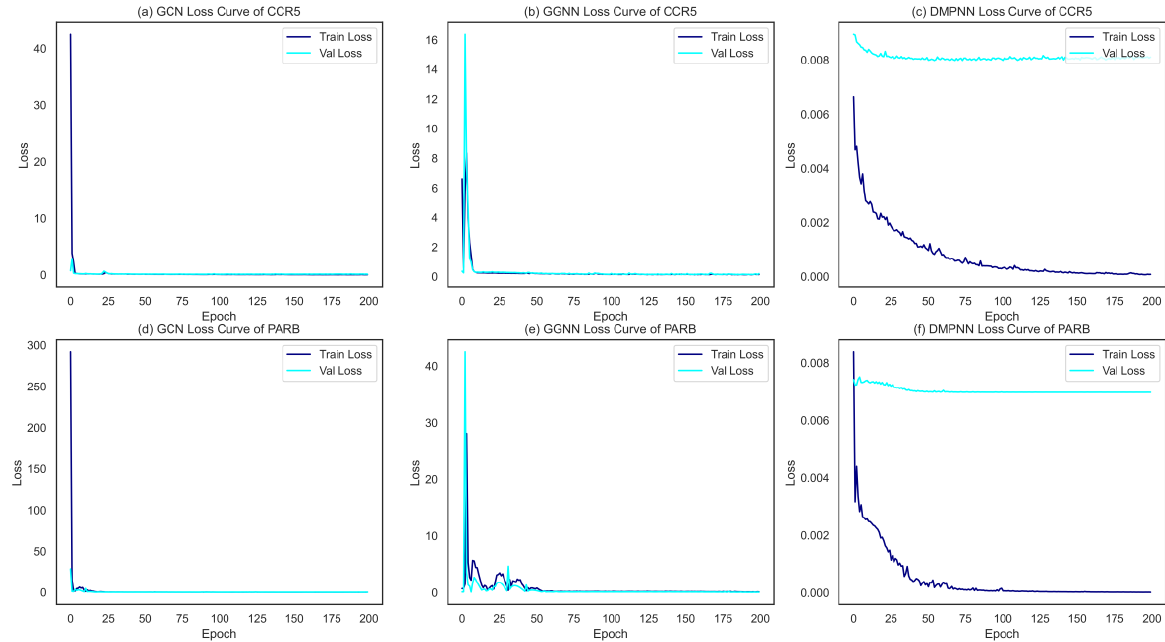
Figure 4. The loss curves of the three GNNs on one HIV-1 target ( a – c ), and one HBV target ( d – f ).